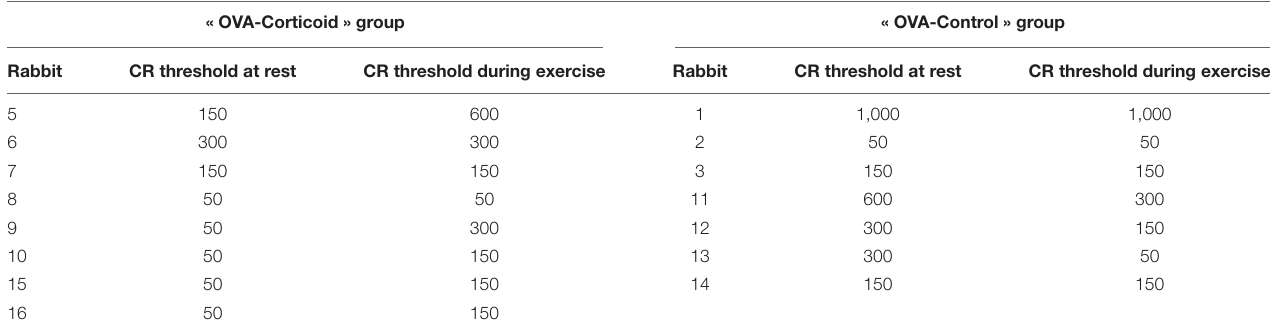
TABLE 1 | Distribution of cough reflex (CR) threshold (expressed in milliseconds) at rest and during exercise in both groups (“OVA-Corticoid” group and “OVA-Control”